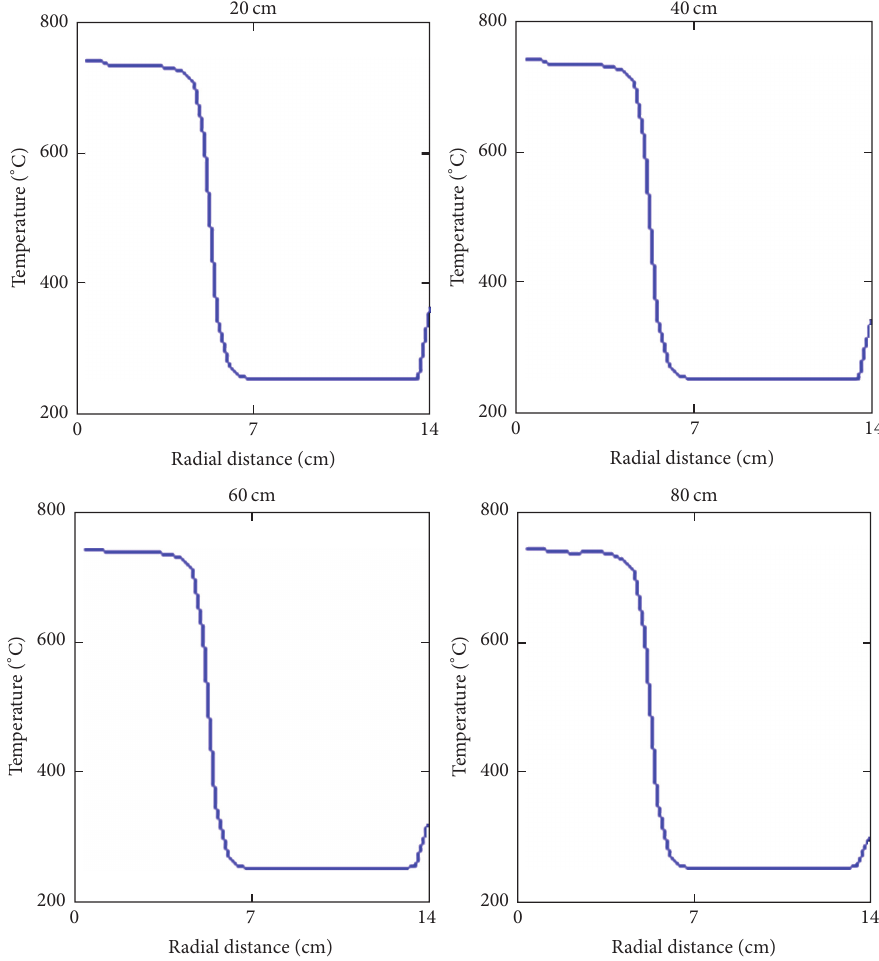
Figure 11: Temperature distribution in radial direction at 20cm, 40 cm, 60 cm, and 80